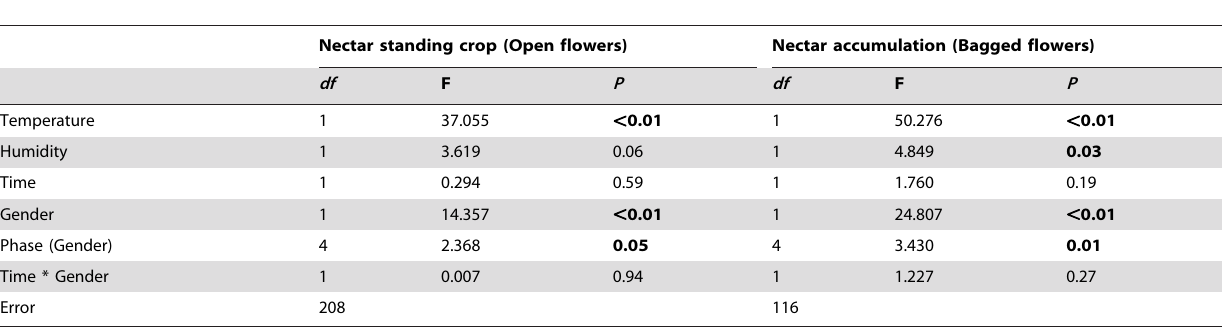
Analyses were performed on log-transformed data. Significant effects are shown in bold.